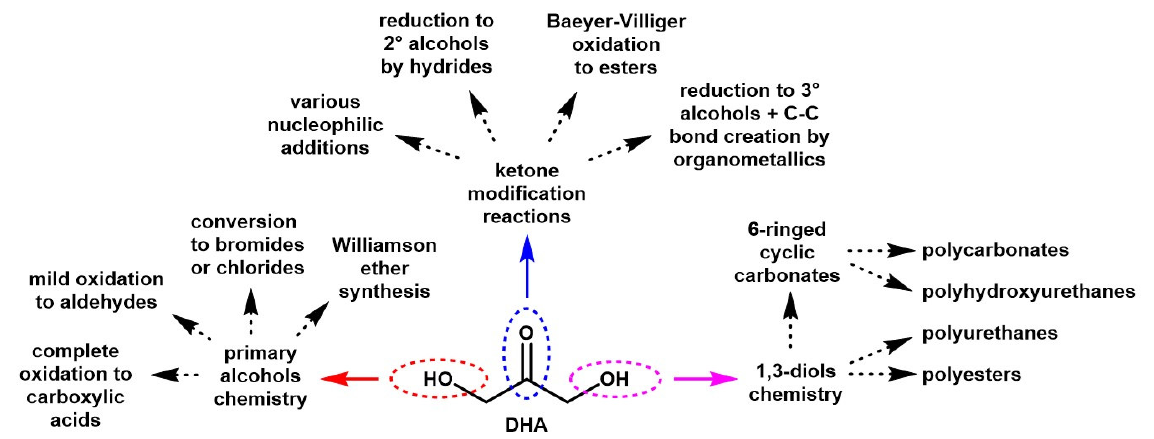
Figure 6. Scheme of the reactive sites of DHA and potential reactions.